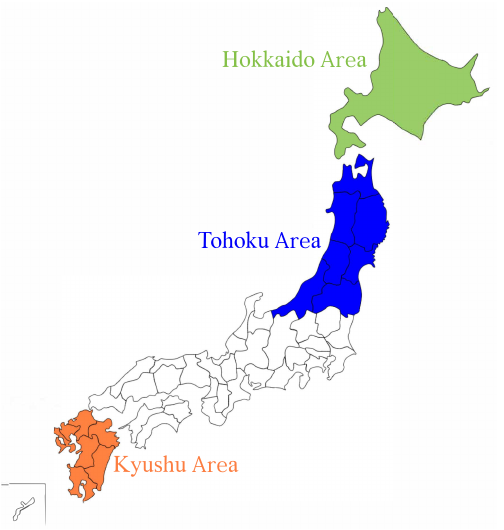
Figure 1. Locations of the three balancing areas considered: Hokkaido, Tohoku, and Kyushu.